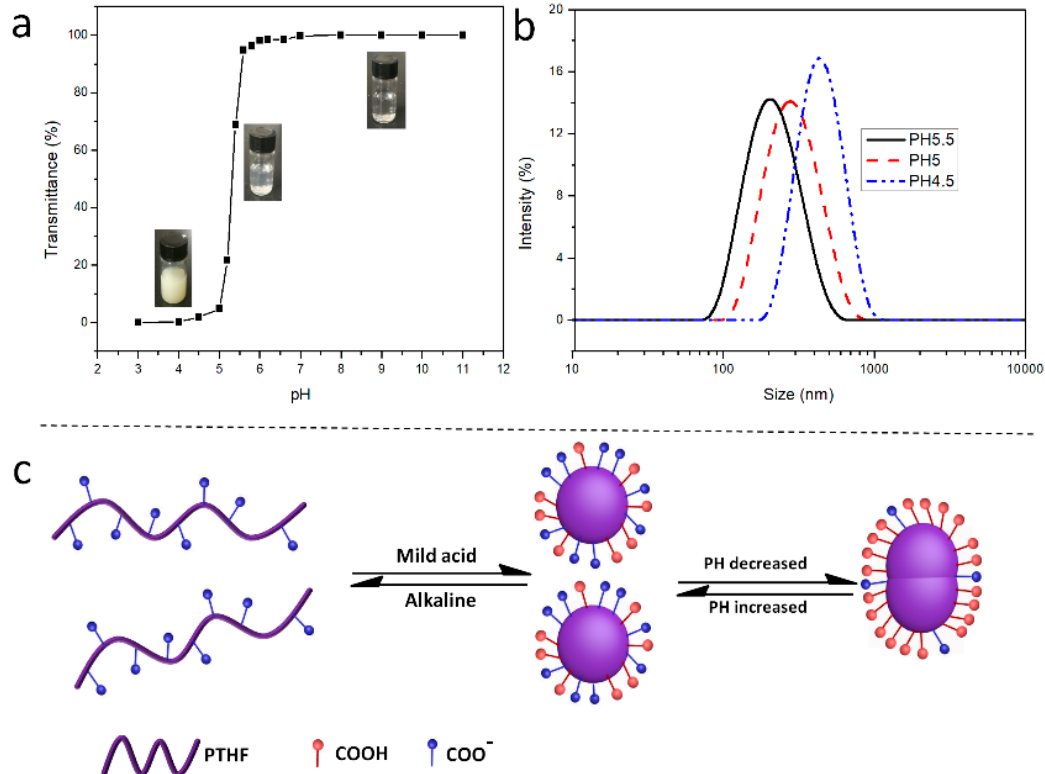
Figure 6. Transmittances of PTHF acid solutions with different pH values ( a ). Dynamic light scattering (DLS) traces of aggregates formed by the self-assembly of PTHF acid in aqueous solution at pH 6, 5, and 4 ( b ), [Polymer] = 0.5 mg mL − 1 . Schematic illustration of the mechanism for the pH-triggered dissolution- assembly-disassembly transition behavior ( c ).